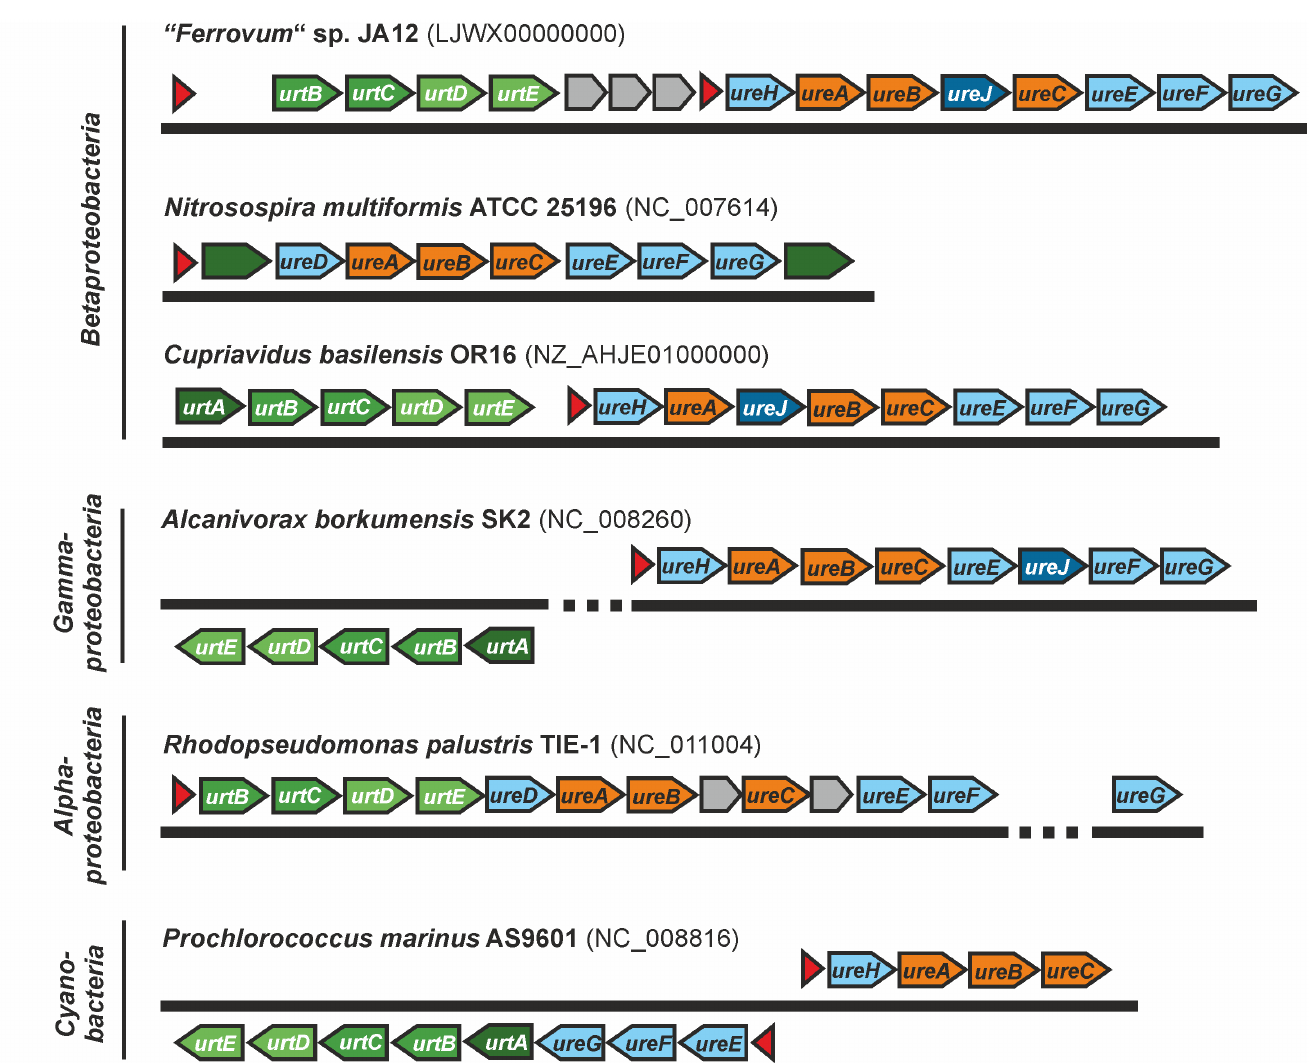
Fig 3. Urease-encoding gene clusters in “ Ferrovum ” strain JA12 and representative bacteria belonging to other taxa. The structure of the urease gene cluster in the genome of “ Ferrovum ” strain JA12 (A) was compared to urease encoding gene clusters of other urease active bacteria (B). With the exception of Nitrosospira multiformis ATCC 25196, which appears to use a urea-specific permease, urea is taken up via an ABC transport system (green), consisting of a periplasmic urea binding protein ( urtA ), two permeases ( urtBC ) and two ATP-hydrolysing enzymes ( urtDE ). The genes predicted to encode the three urease subunits ( ureABC , orange), the Ni 2+ transporter ( ureJ , dark blue) and the urease accessory proteins ( ureH , ureEFG , light blue) are often co- localised with the urea transporter. The accessory proteins encoded by ureH and ureD are thought to fulfil the same function during the formation of the active urease. Genes encoding other proteins involved in nitrogen metabolism are shown in grey. The location of potential promotors (red) were predicted using FGENESB.